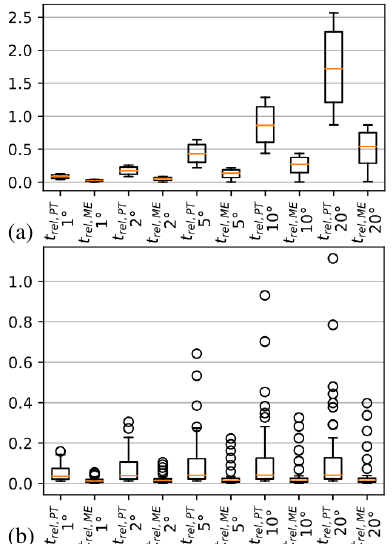
Figure 13. Relative rotation of the right half, neighboring undeformed triangles to ⃗p def,h in blue with cyan red bordered vertices. Figure 14. (a) Triangular mesh (reference state) with separation plane (blue), left side with green points and right side with red points; (b) mesh (deformed state) and error vector field for the model of PT (scale factor: 20) for 10° relative rotation; (c) mesh (deformed state) and error vector field for ME (scale factor: 20).